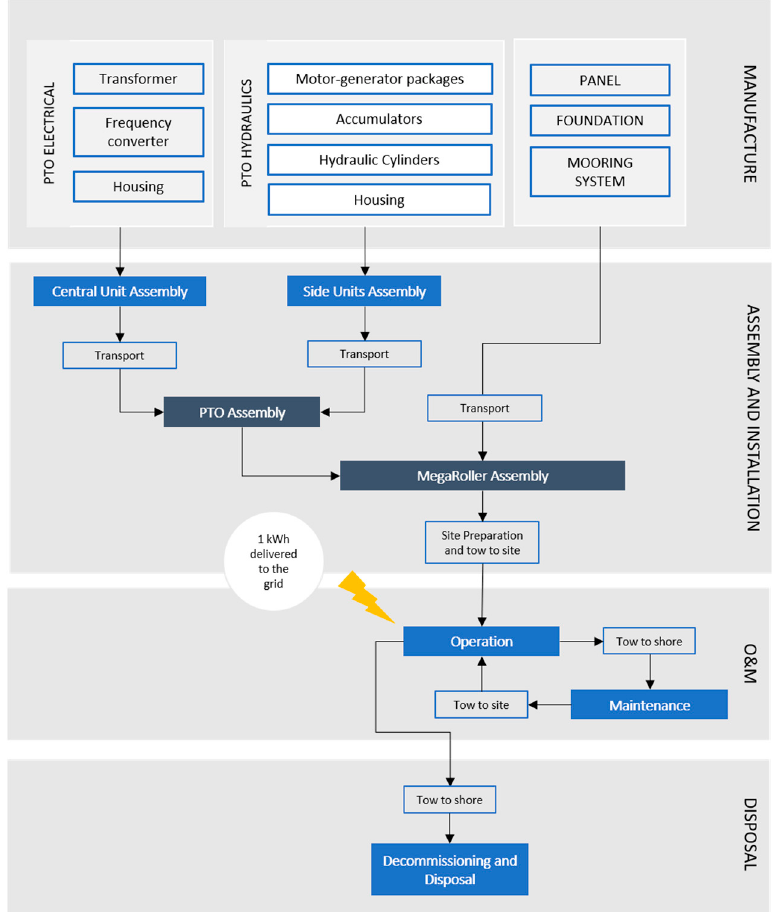
Figure 3. Flowchart of the life cycle of MegaRoller.